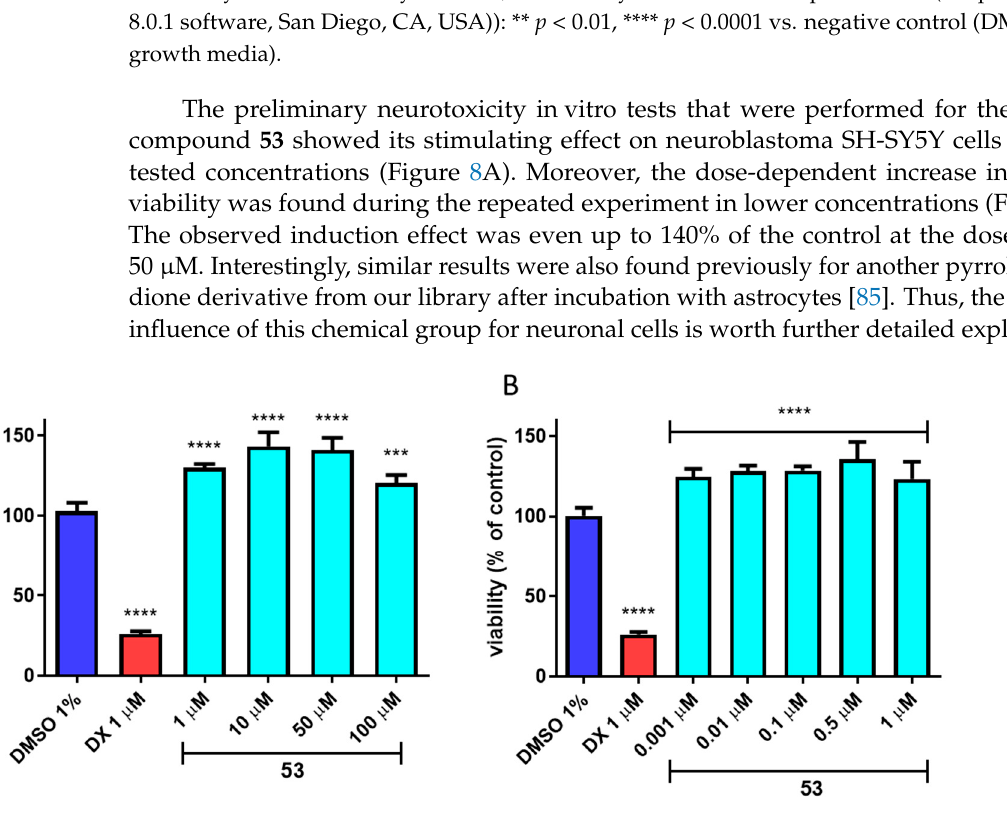
Figure 8. The effect of 53 and the cytostatic drug doxorubicin (DX) on neuroblastoma SH-SY5Y cell line viability after 72 h of incubation at 37°C, 5% CO 2 in the concentration range 1–100 μ M ( A ) and 0.001–1 µ M ( B ). The data were analyzed with one-way ANOVA, followed by Bonferroni’s Comparison Test (Graph Pad Prism 8.0.1 software, San Diego, CA, USA)): *** p < 0.001, **** p < 0.0001 vs. negative control (DMSO 1% in growth media).